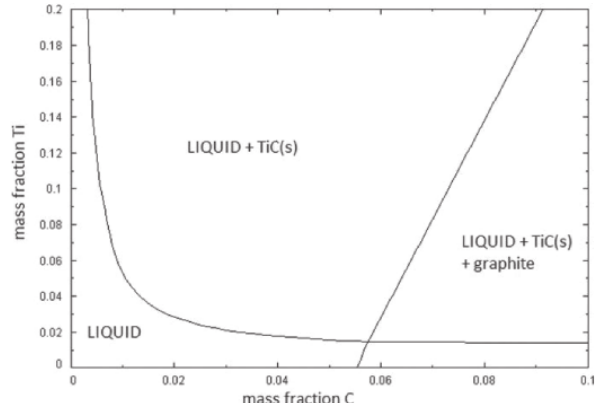
Fig. 14: Fe-Ti-C system at 1823 K